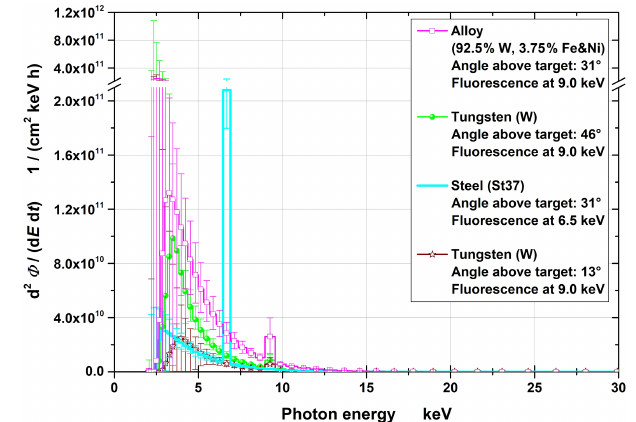
Figure 4. Photon fluence spectra (normalized to 1h effective irra- diation time and 10cm distance) together with their 95% coverage intervals. Note the broken